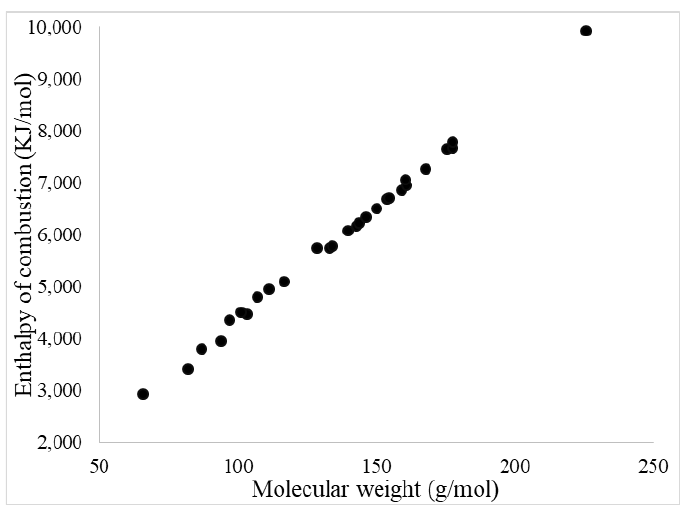
Figure 16. The effect of molecular weight of blends on enthalpy of combustion .